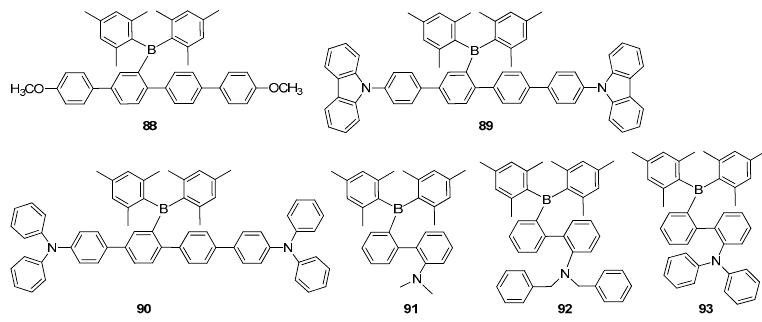
Figure 15. π -Conjugated materials 88 – 93 with Mes 2 B pendants.